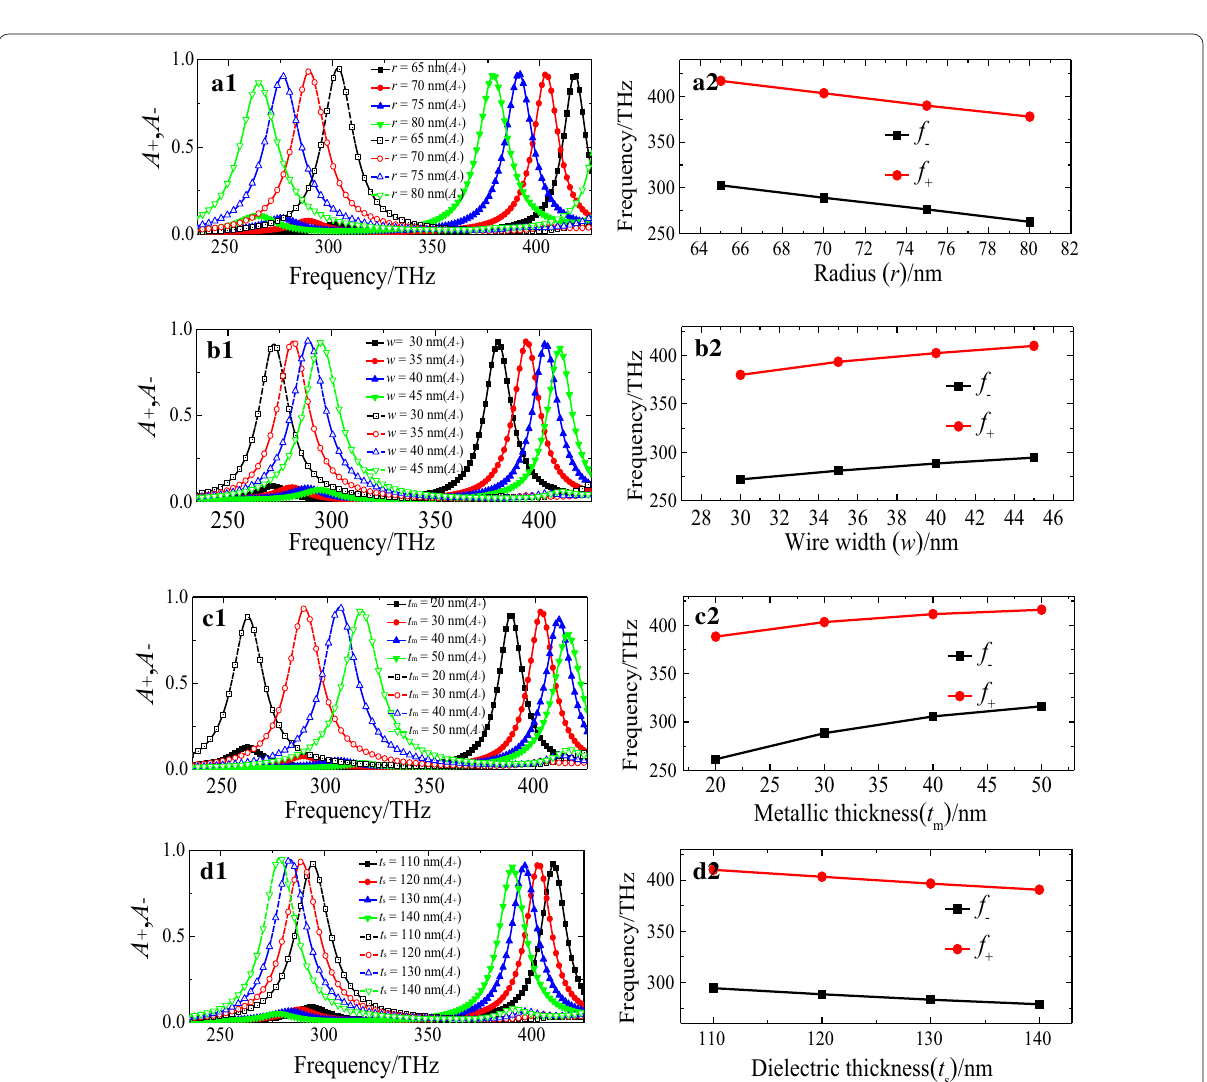
Fig. 6 The simulated ( a1 – d1 ) absorbance spectra and ( a2 – d2 ) resonance frequencies ( f different geometric parameters: ( a1 , a2 ) radius ( r ), ( b1 , b2 ) wire width ( w ), and ( c1 , c2 ) thickness ( t m ) of semicircle nanostructure, ( d1 , d2 ) thickness of dielectric substrate ( t s